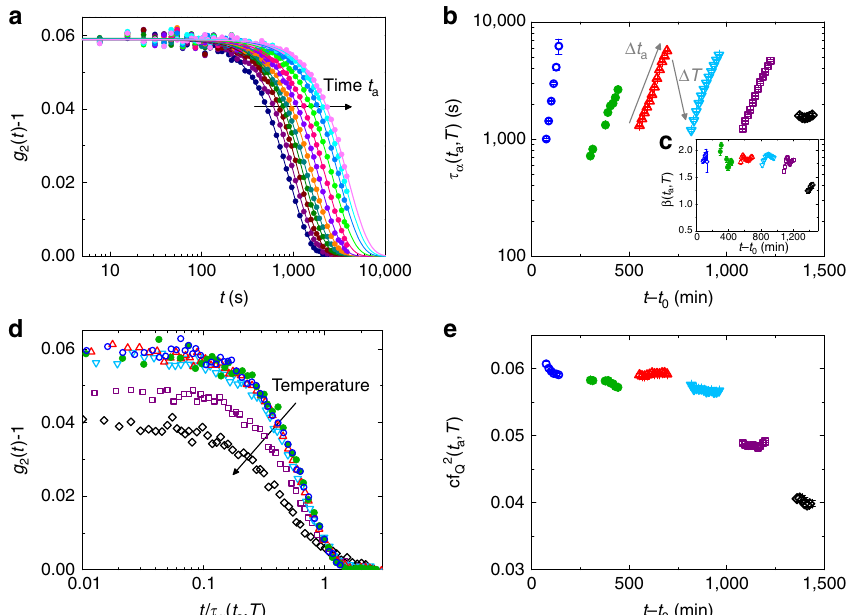
Figure 1 | Temperature and age dependence of the relaxation dynamics. ( a ) Temporal evolution of intensity–intensity correlation functions measured with XCPS for q 0 ¼ 2.81Å (cid:2) 1 during isotherm at T ¼ 453K. Data are reported after baseline subtraction together with the fits obtained by the Kohlrausch–Williams–Watts model (see text). The arrow indicates the evolution with annealing time, t a from temperature equilibration. ( b ) Temporal and T evolution of the structural relaxation time measured with XPCS as a function of t (cid:2) t 0 , where t 0 is the time corresponding to the beginning of the heating protocol. ( c ) Corresponding shape parameters. ( d ) Selection of intensity correlation functions measured at fixed t a and different T reported as a function of t / t a ( t a , T ). ( e ) Temporal and T evolution of the initial plateau value, cf q ( T ) 2 , as a function of t (cid:2) t 0 . In ( b – e ) T steps are: 393K (blue empty circles), 433K (green full circles), 453K (red triangles), 473K (cyan down triangles), 493K (purple squares) and 513K (black